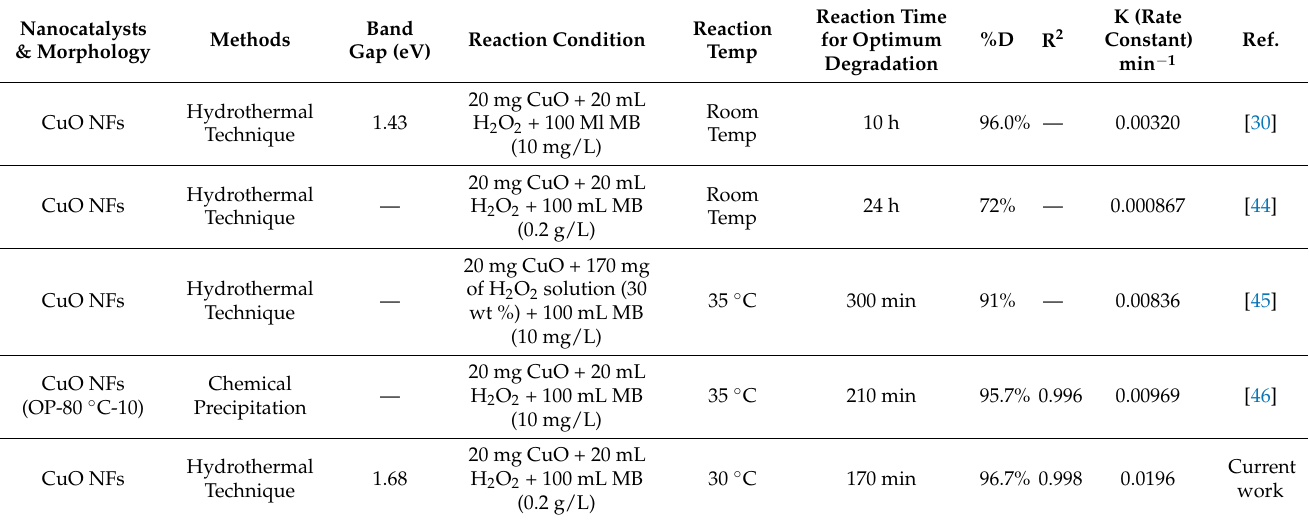
Table 1. Copper oxide nanoflowers in the presence of H 2 O 2 for the degradation of MB dye solution. Nanocatalysts & Morphology